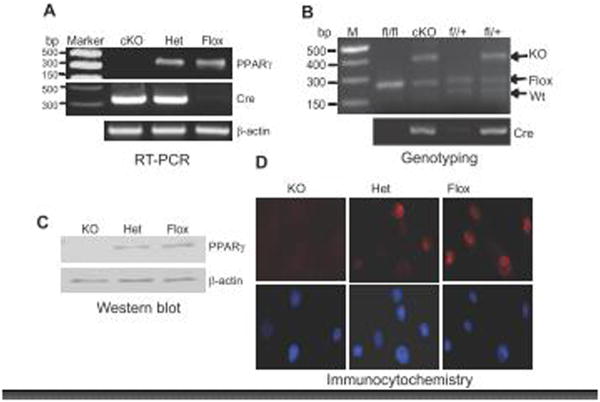
Characterization of BMSCs isolated from the PPARγ cKO mice(A) RT-PCR analysis showing the expression of PPARγ and Cre mRNA in BMSCs isolated from PPARγ cKO, heterozygous (Het), and Floxed (Flox) mice. (B) Genotyping results showing distinct PCR products amplified from tail genomic DNA. KO and floxed PPARγ alleles are indicated. WT: tail DNA from a wild-type mouse was used as template in PCR reaction to show the wild type allele. (C, D) Western blot (C) and immunofluorescence labeling (D) showing PPARγ protein expression in BMSCs.